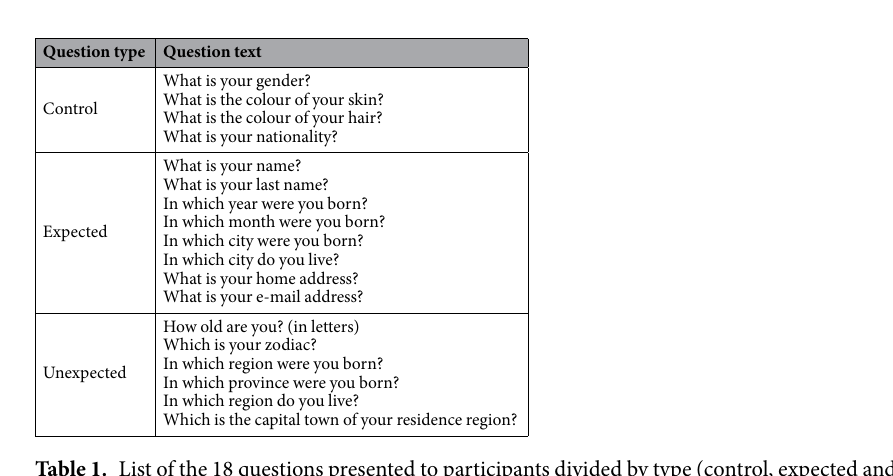
Figure 1. Example of the computer screen. Participant were instructed to respond writing in the edit box which was located below the presented sentence. The subject was instructed to finish the response pressing ENTER.